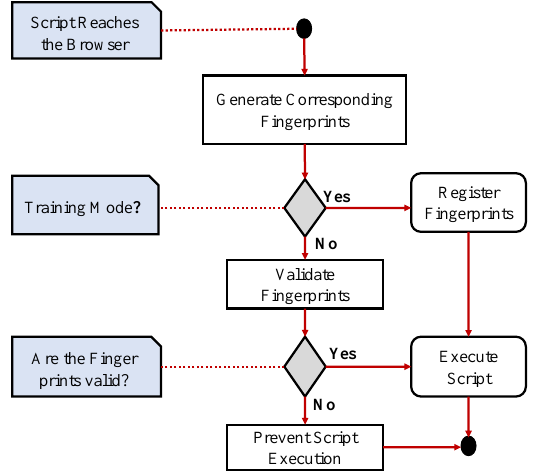
Figure 7. Browser and device interaction with Site